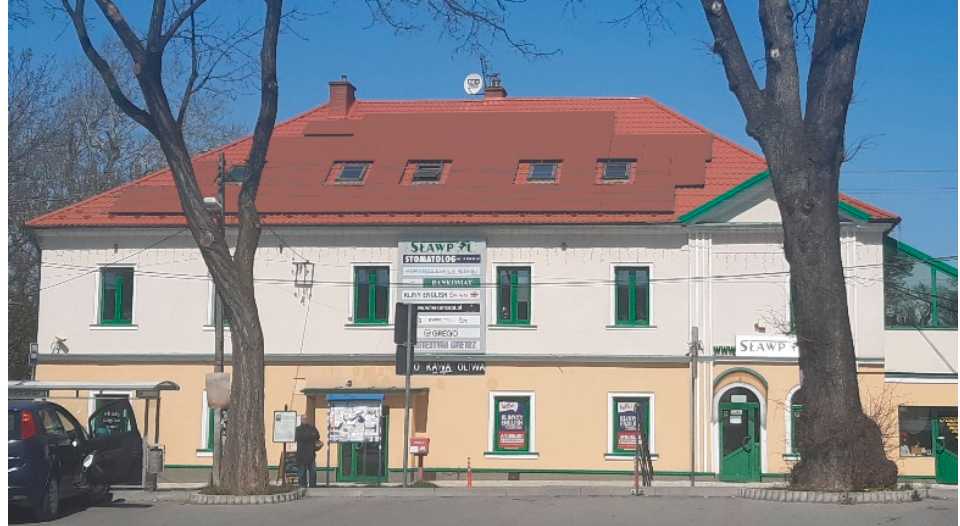
Figure 14. Harmonized color composition on the building’s roof with the application of a new generation of color PV panels (computer simulation by P. Filipek).